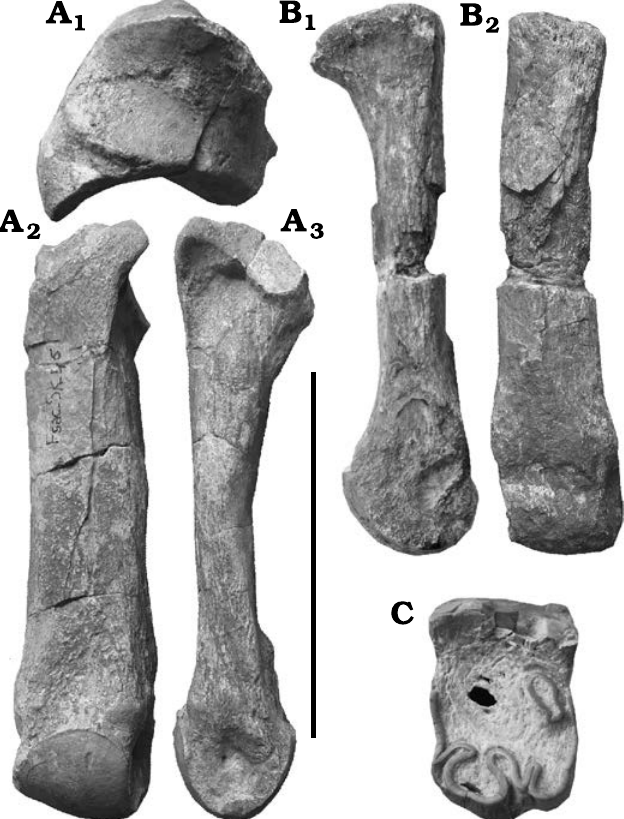
Fig. 3. Elasmotheriine rhinoceros Eoazara xerrii gen. et sp. nov. from the upper Miocene of Skoura, Morocco. A . Second left metacarpal (FSC-Sk-45) in proximal (A 1 ), anterior (A 2 ), and lateral (A 3 ) views. B . Imperfectly preserved right second metatarsal (FSC-Sk-53) in anterior (B 1 ) and lateral (B 2 ) views. C . Left first upper molar (FSC-Sk-33) in occlu- sal view. Scale bars: A, 50 mm; B, C, 100 mm.